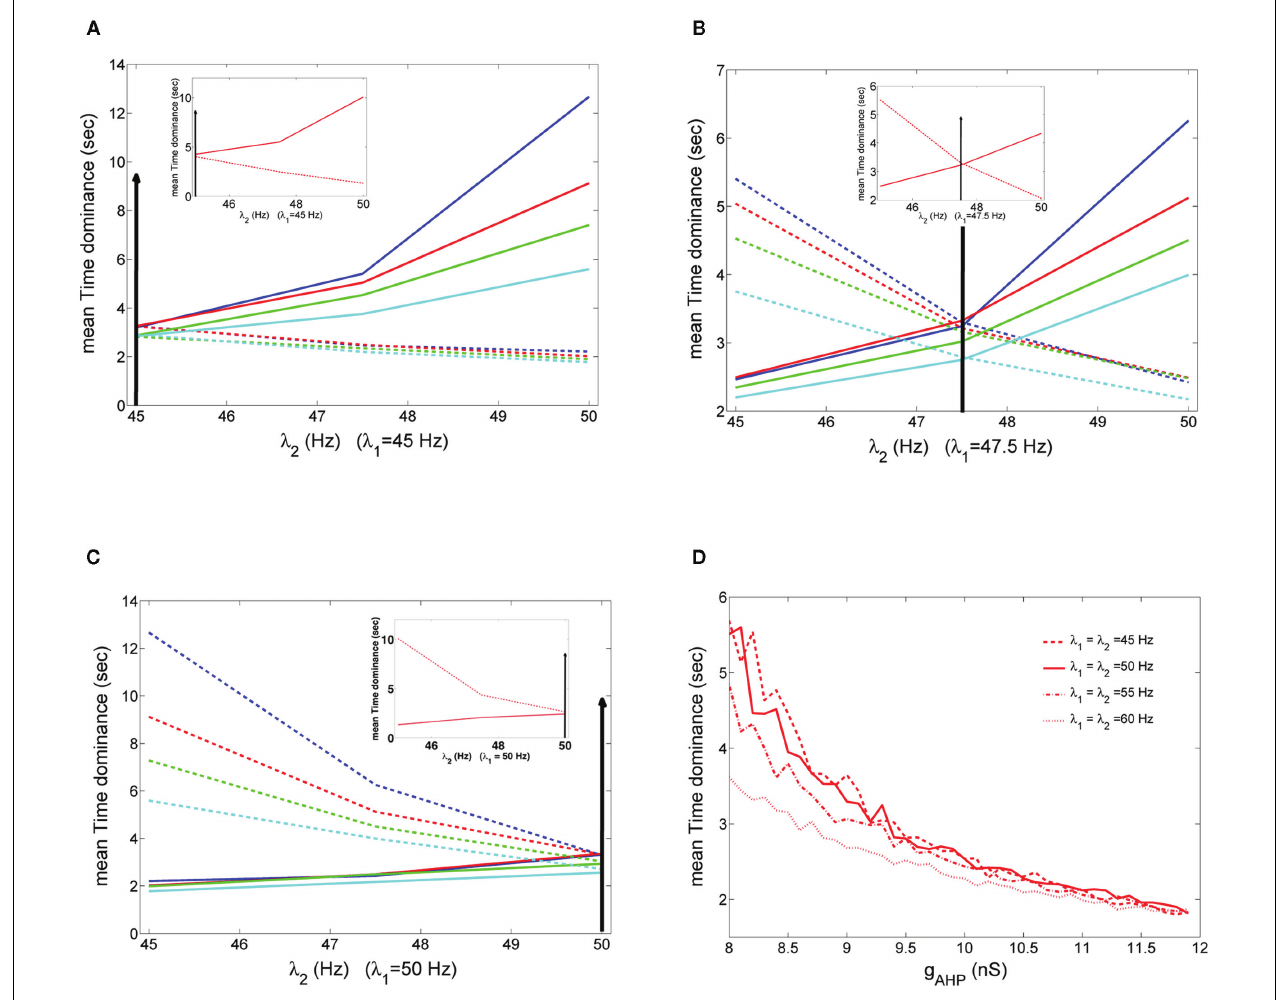
where both populations receive the same stimulus, λ 1 = λ 2 . In the insets the same are plotted for the case where inhibitory interneurons are adapted (red big circle in Figures 8A,B ). A: when λ 1 = 45Hz, (B) when λ 1 = 47.5Hz and (C) when λ 1 = 50Hz. (D) Mean time dominance of both populations for different stimulus strengths when inhibitory interneurons are not adapted and n =